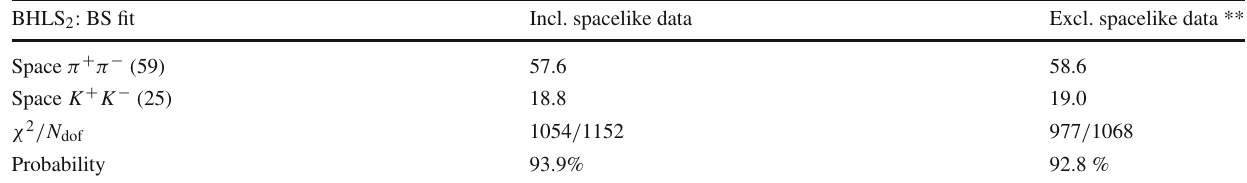
Table 4 BS variant global fits excluding τ data: The leftmost data column shows the partial χ 2 in the fit including both kinds of space- like data, the rightmost one shows the corresponding results in the fit